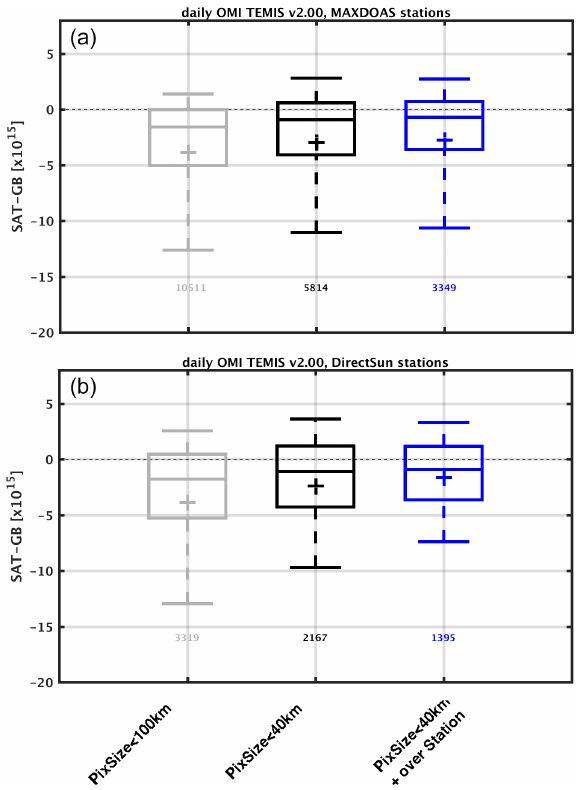
Figure 8. Box-and-whisker plot of the daily OMI DOMINO v2.0 biases for all the stations and for different possibilities of pixel size selection (pixels smaller than 100km in grey, smaller than 40km in black and with filtering on pixels only above the station in blue). First row: ensemble of MAX-DOAS stations; second row: ensemble of direct sun stations. The box-and-whisker plots are defined as in Fig. 7. The number of comparison points for each case is shown in the corresponding